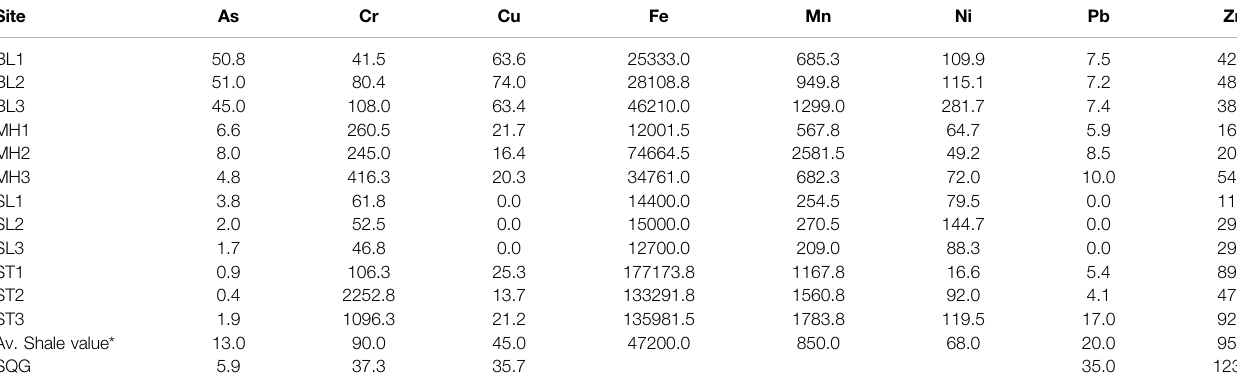
TABLE 3 | Mean metal concentrations in the sediments of the four rivers, the average shale values and sediment quality guidelines. Site